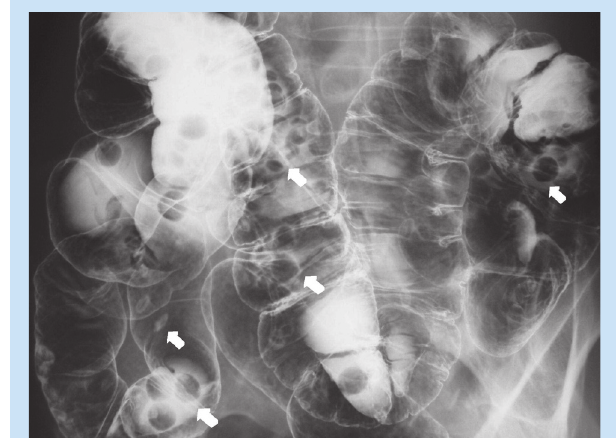
Fig. 2b. Mealie pips (arrows) simulating polyps.